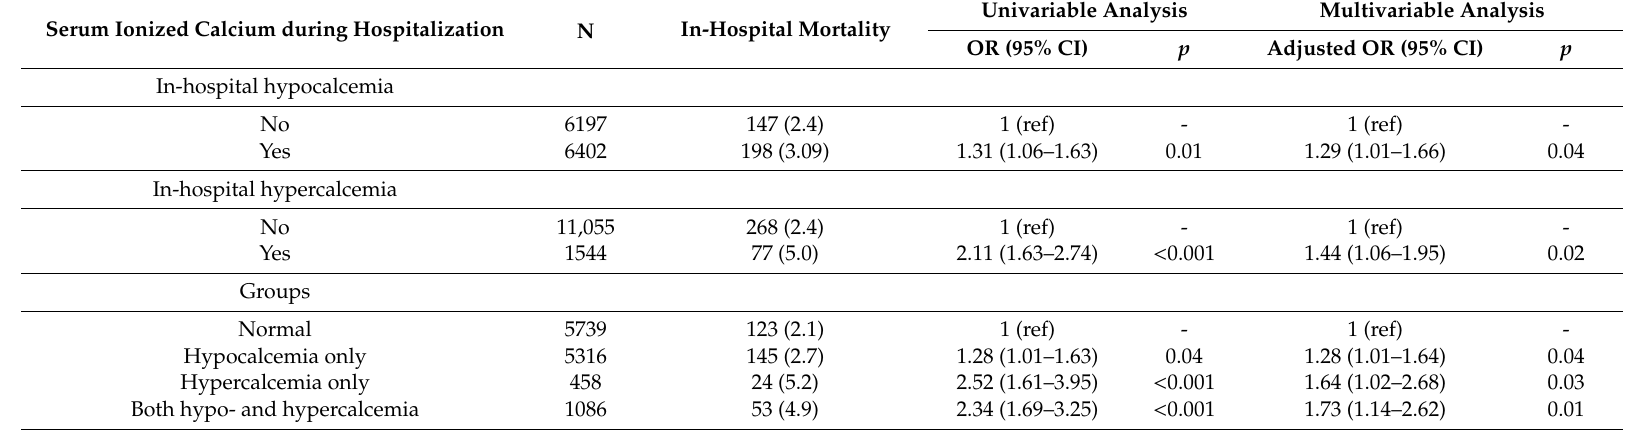
Table 2. Association between in-hospital serum ionized calcium derangements and in-hospital mortality. Serum Ionized Calcium during